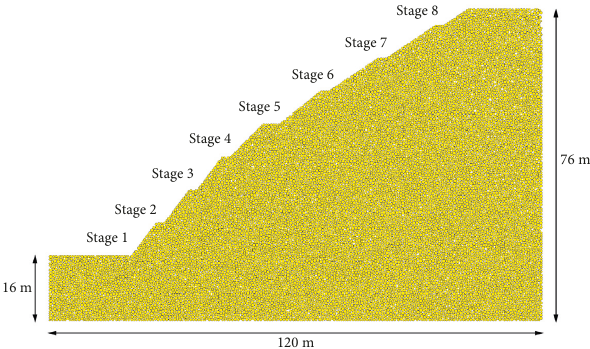
Figure 1: Linear parallel bonding model.